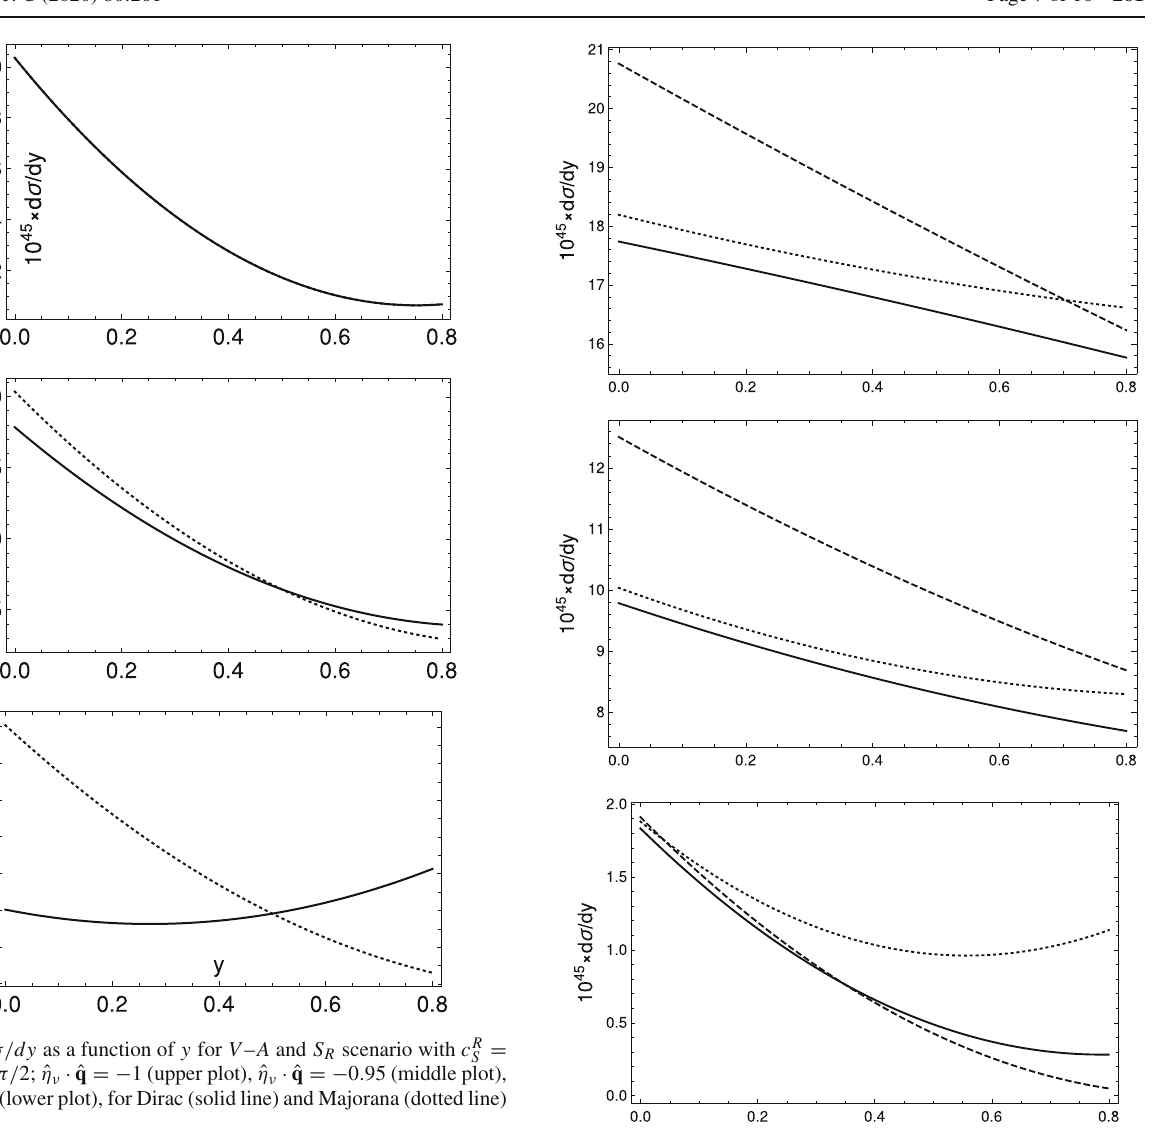
Fig. 9 d σ/ dy as a function of y for V – A and S R scenario with c R 0 . 3, θ 1 = π/ 2; ˆ η ν · ˆ q = − 1 (upper plot), ˆ η ν · ˆ q = − 0 . 95 (middle plot), ˆ η ν · ˆ q = 0 (lower plot), for Dirac (solid line) and Majorana (dotted line) ν e s